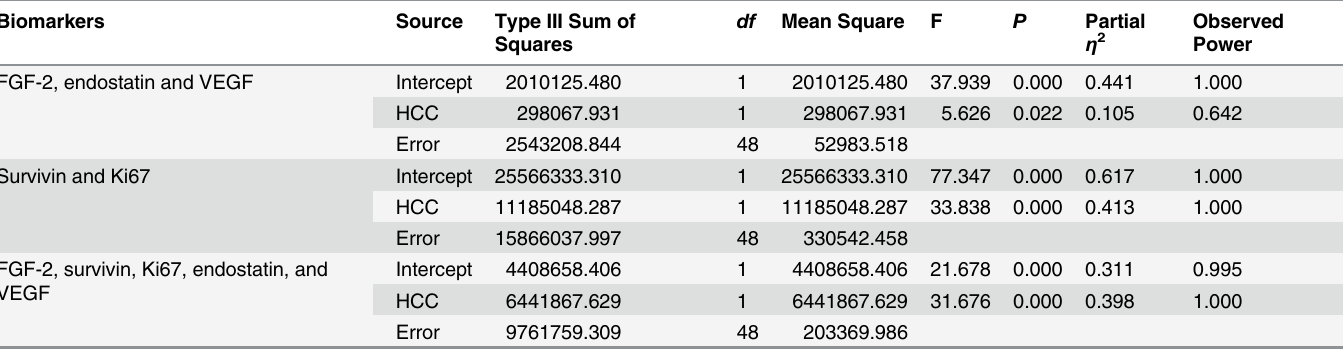
Table 3. Tests of between-subjects effects on biomarkers in living donor liver transplantation with hepatocellular carcinoma